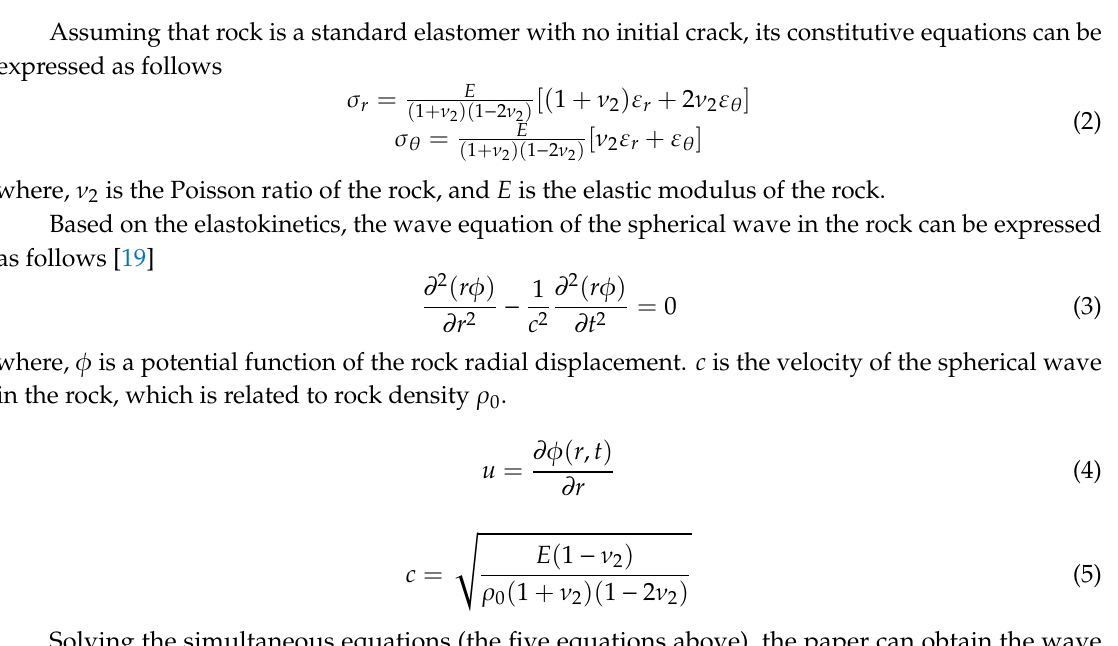
Figure 8. Schematic diagram of stress wave transmission in rock.